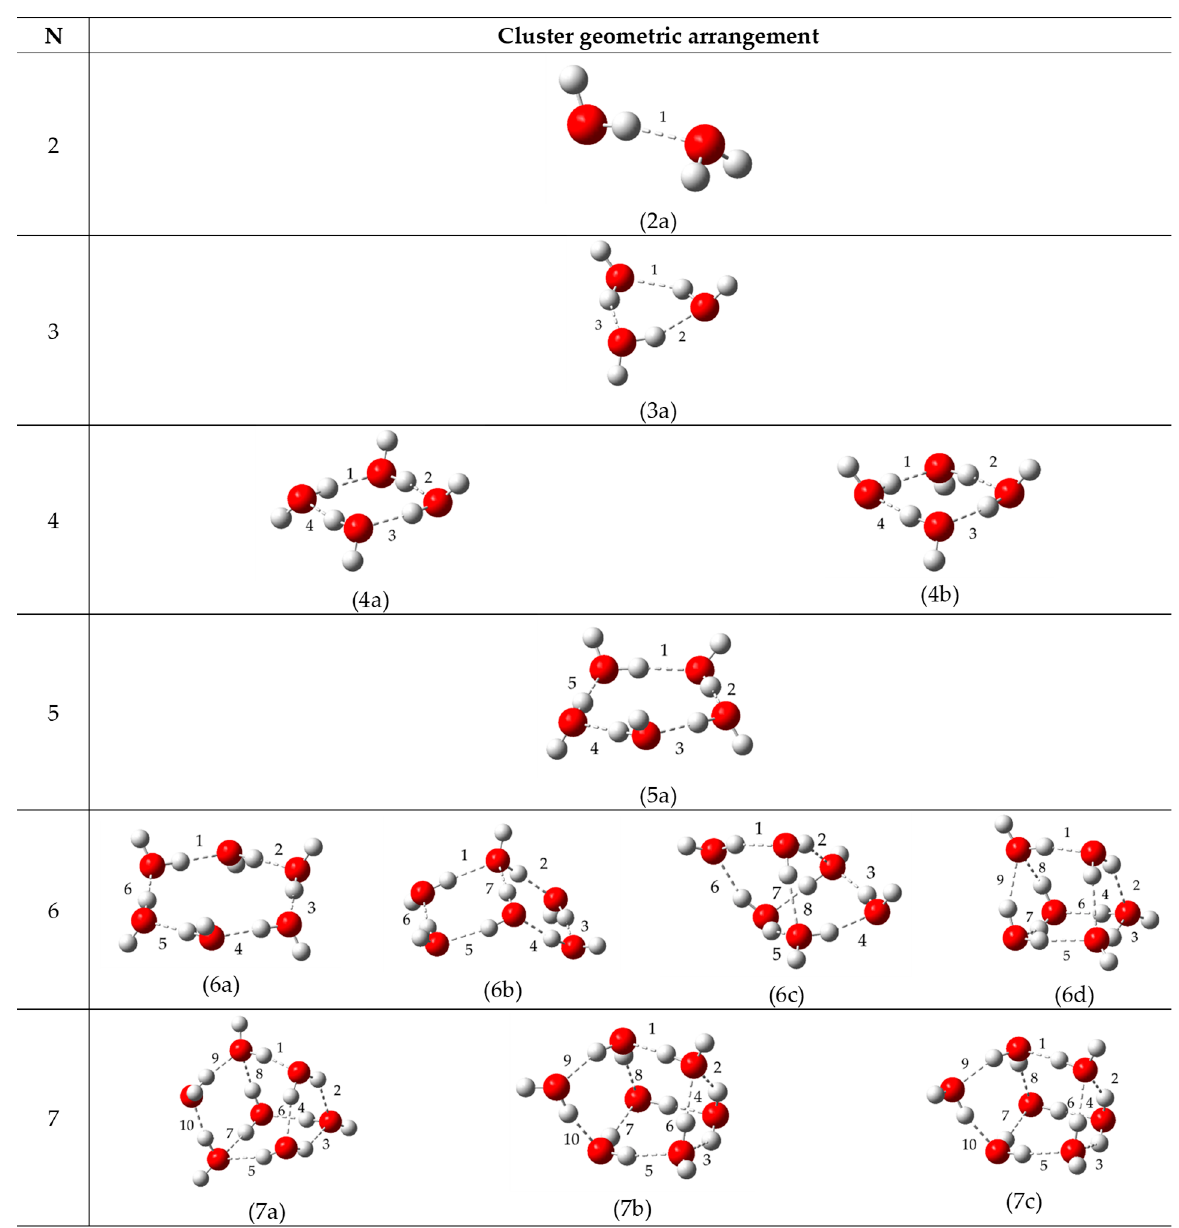
Figure 2. Equilibrium geometries of water clusters considered in the present study. Here 2a shows the dimer geometry, 3a, 4a, 4b, 5a and 6a shows the geometries of the 2D ring clusters. Finally, 6b, 6c, 6d, 7a, 7b and 7c depict the geometries for the 3D clusters.